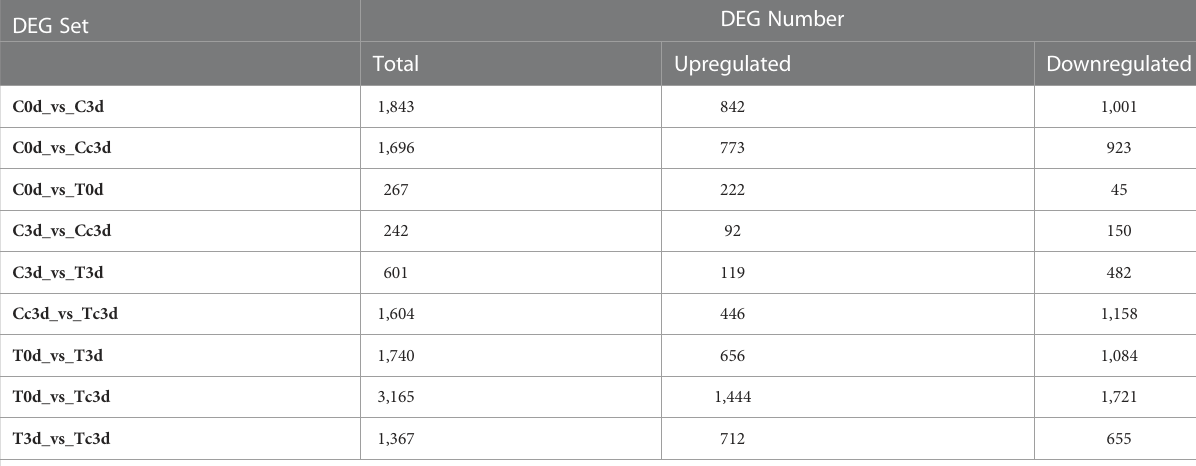
TABLE 3 Numbers of differentially expressed genes in various comparing groups. DEG